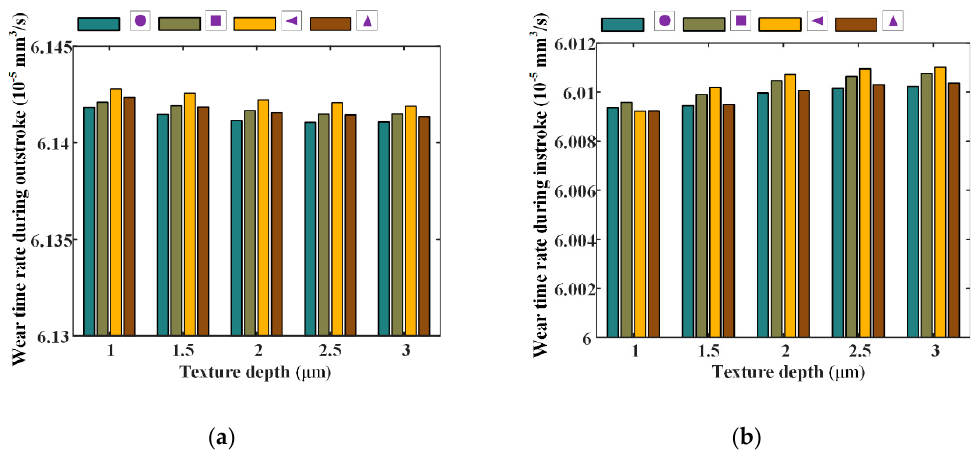
Figure 22. The relationship between wear time rate and texture depth, ( a ) outstroke, ( b ) instroke.